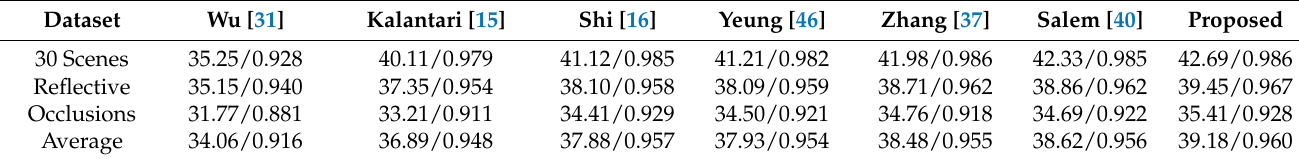
Table 2. The proposed model’s numerical comparison (PSNR/SSIM) to reconstruct 8 × 8 out of 2 × 2 views: extrapolation 0.